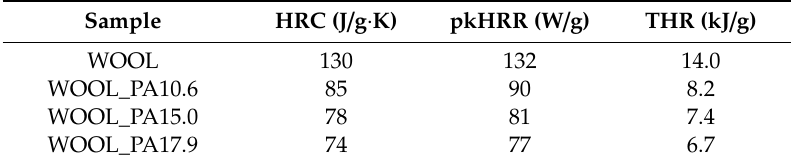
Table 14. Results from the microscale combustion calorimetry tests for untreated (WOOL) and PA-treated (WOOL_PA) wool